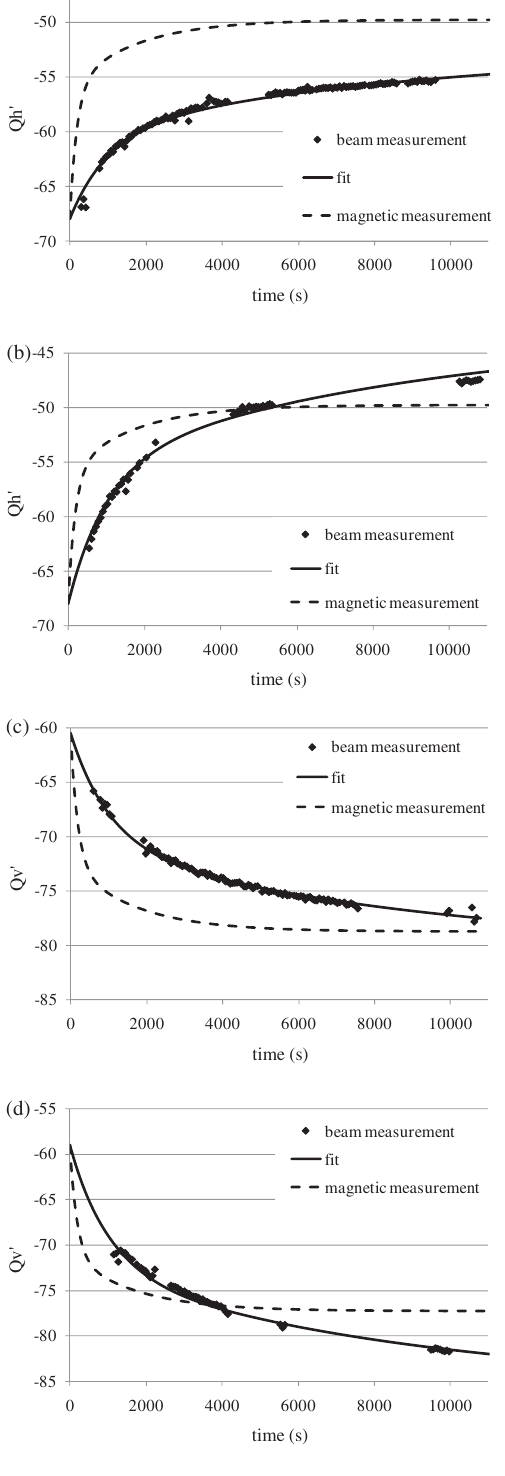
FIG. 6. Average chromaticity as measured during magnetic measurements (dashed line) compared with the measured chro- maticity during beam measurements (dots) and its respective fit (continuous line). Parts (a) and (b) are the horizontal chroma- ticity for beam 1 and beam 2, respectively, and (c) and (d) are the vertical chromaticity for beam 1 and beam 2,